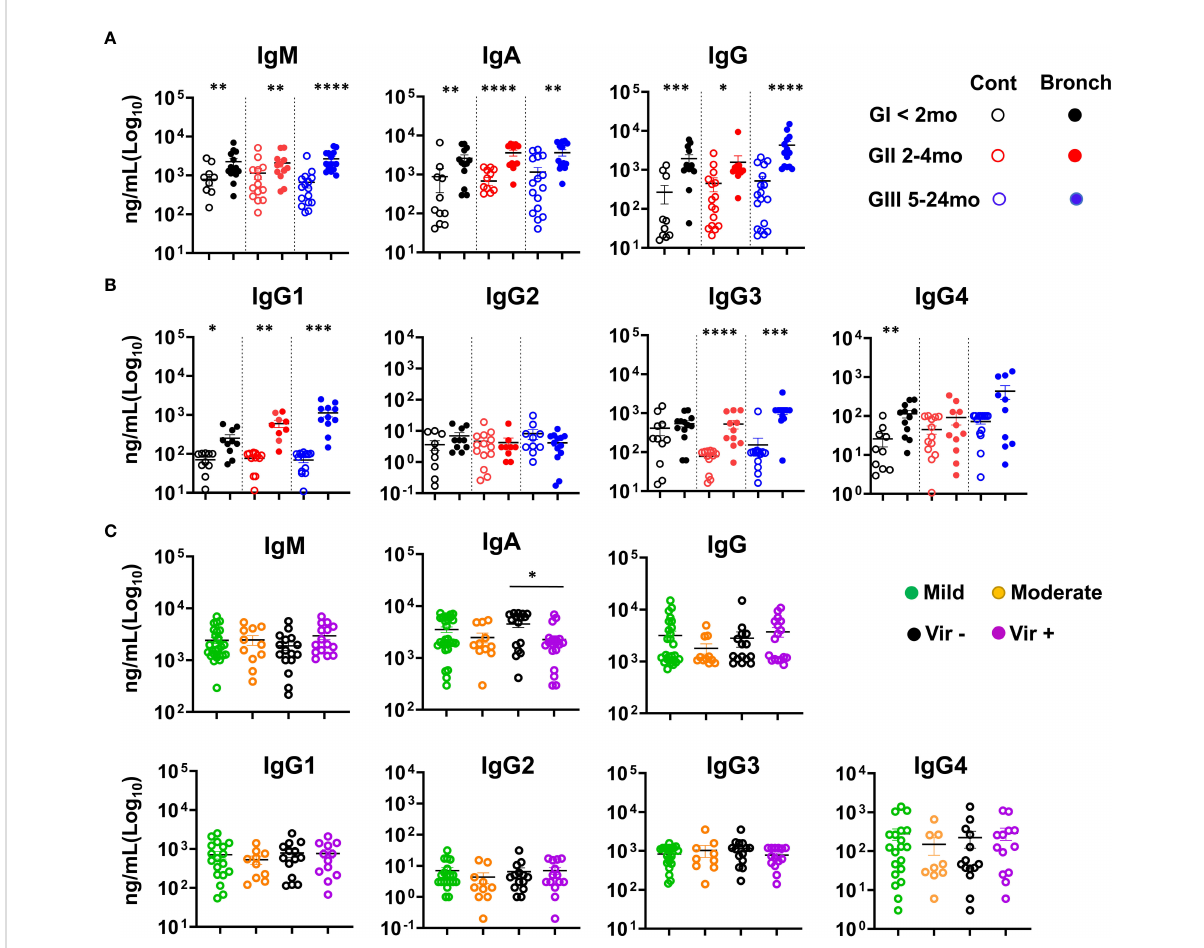
FIGURE 3 Bronchiolitis NLF samples contain elevated levels of Immunoglobulins. IgS were quanti fi ed in NLF supernatants from controls and bronchiolitis patients. The scatter dot plots represent individual values, and the mean ± SEM is depicted for each group. Statistical analyses were performed using non-parametric Mann-Whitney sum rank test. (A) IgM, IgA and IgG were determined by ELISA GI (controls n = 12, bronchiolitis n = 14), GII (controls n = 15, bronchiolitis n = 12), and GIII (controls n = 15 bronchiolitis n =14). (B) Cytometric bead array determination (CBA) for IgG1, IgG2, IgG3 and IgG4. GI (controls n = 10, bronchiolitis n = 11), GII (controls n = 14, bronchiolitis n = 9), and GIII (controls n = 14 bronchiolitis n = 10). (C) Ig isotype quanti fi cation based on mild (n = 29) and moderate (n = 11) bronchiolitis severity, and on the presence/absence of respiratory viruses (absence of viruses, n = 17; presence of viruses, n = 19). *p < 0.05; **p < 0.01; ***p < 0.001; ****p <